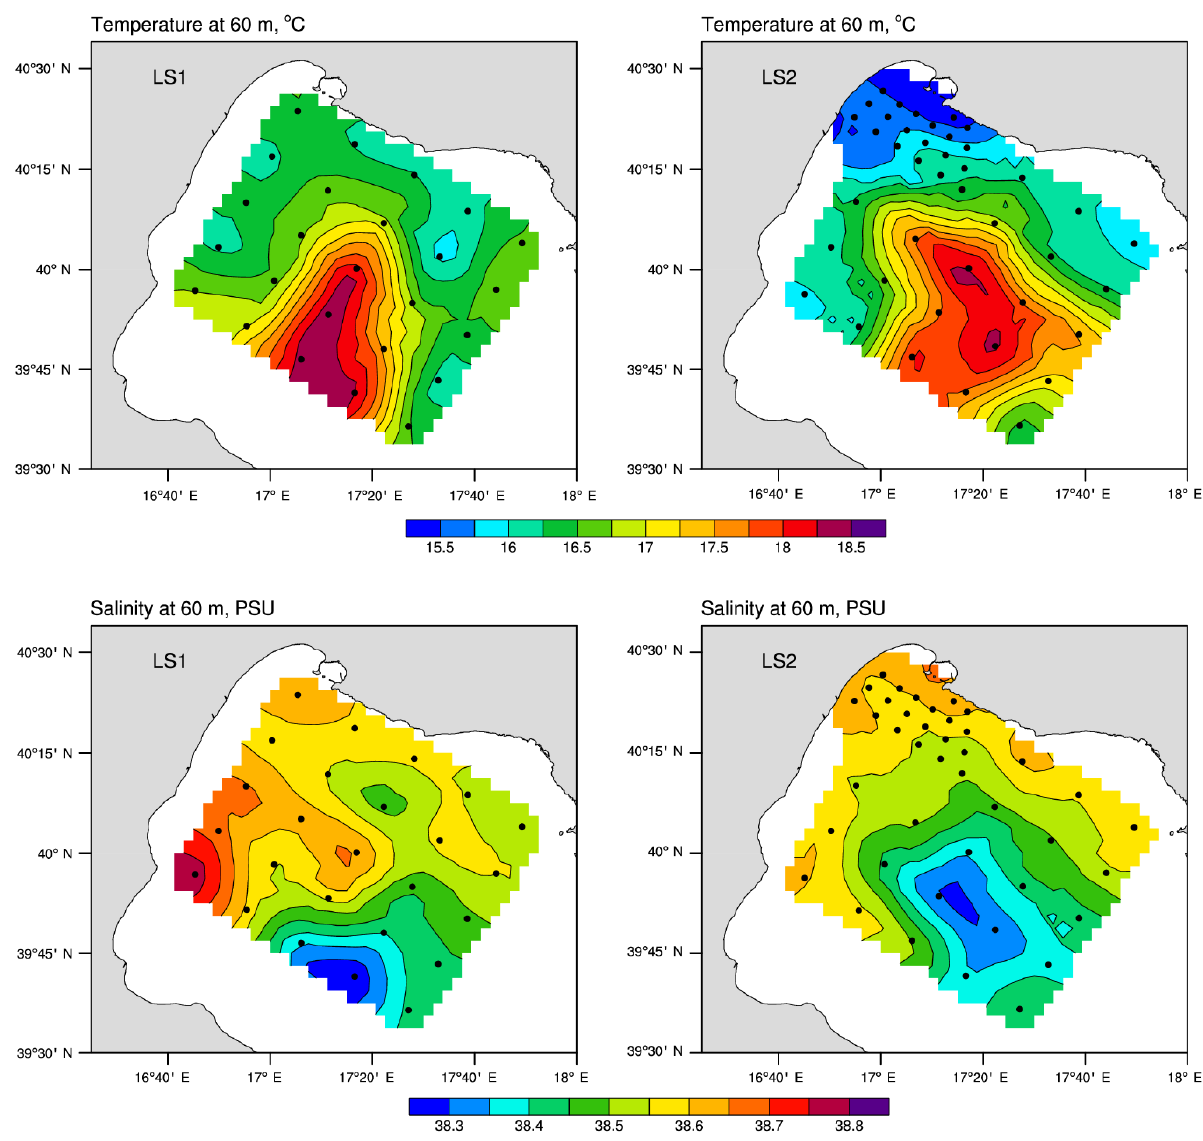
Figure 11. Seasonal thermocline (60m) temperature (top) and salinity (bottom) mapping for LS1 (left panel) and LS2 (right